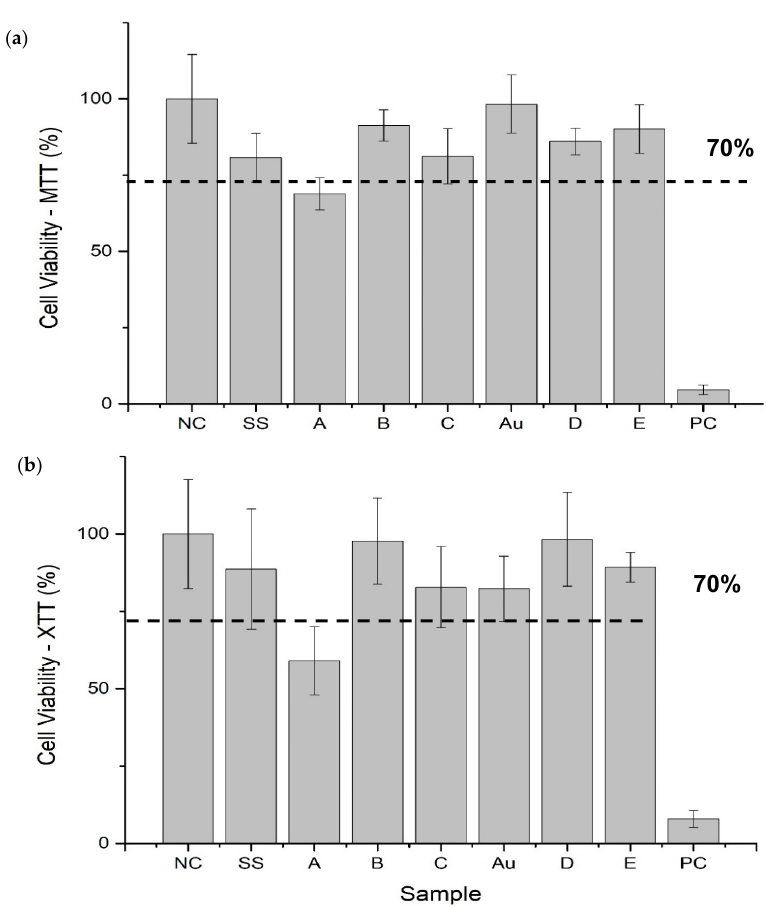
Figure 4. Results of the ( a ) MTT and ( b ) XTT tests for obtained materials.